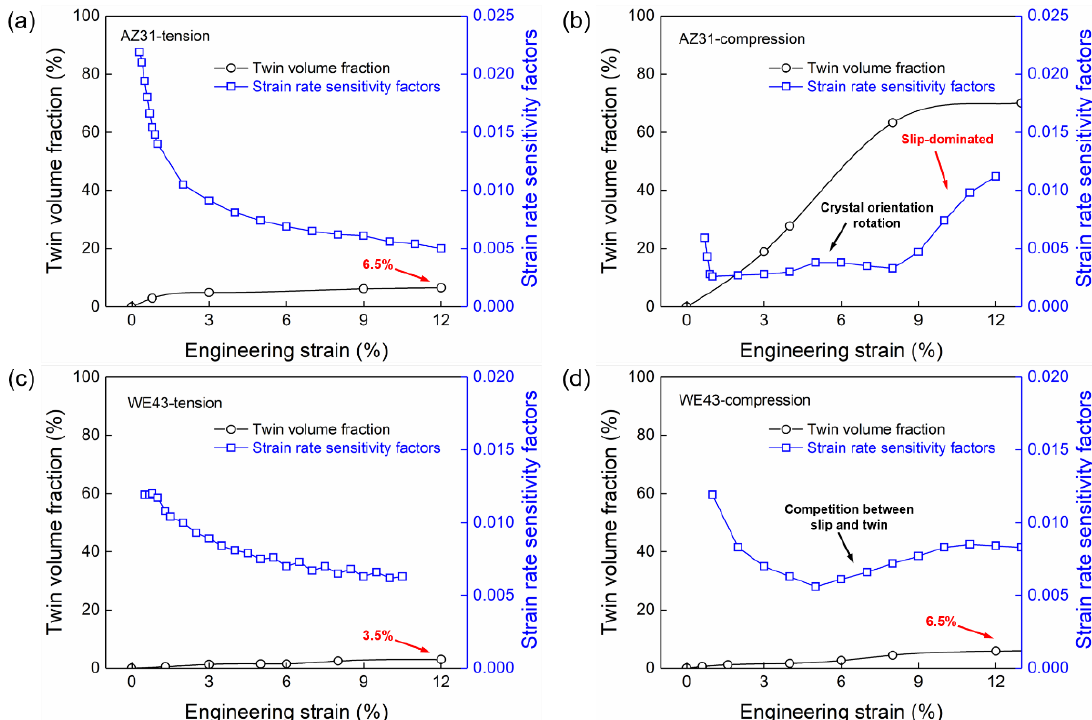
Figure 8. The evolution of twin volume fraction and strain rate sensitivity factors of ( a , b ) AZ31 and ( c , d ) WE43 alloys during uniaxial tension and compression. ( a ) The maximum value of the TVF during AZ31 tension increased slightly by 6.5%. It indicated that this process was dominated by slip deformation. ( b ) For the AZ31 compression, the TVF rapidly ascended at the strain level of 1~9%, which was attributed to the abundance of twin nucleation and growth. It indicated that the SRS factors appeared as a negative SRS at this deformation stage. As the strain increased to 12%, the TVF of AZ31 tend to stabilize. The influence of twinning behavior on sample deformation gradually decreased, and a non-basal plane slip system was activated to accommodate deformation, leading to the increase of SRS. ( c ) The trend of TVF of WE43 alloy was similar to AZ31 during tension deformation. ( d ) The SRS factor of WE43 was affected by the presence of a small amount of twinning during compression, and the fluctuation of SRS was mainly attributed to competition between slip-twin deformation processes.